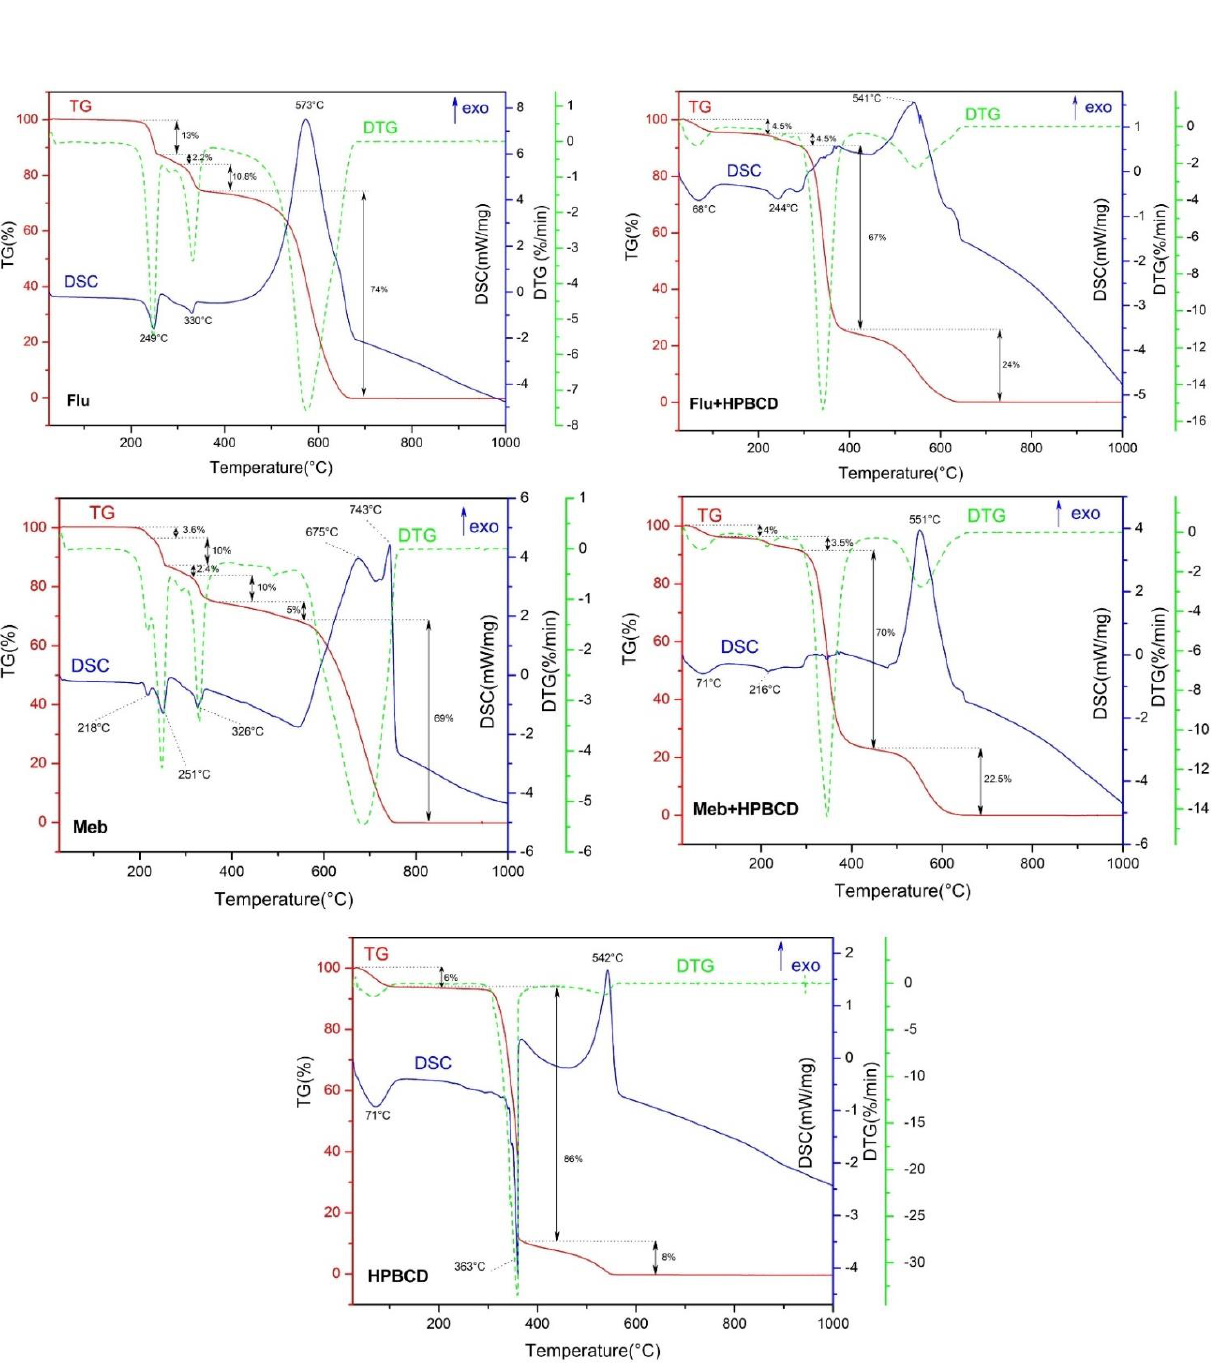
Figure 5. Thermal analysis for FLU, MEB, and their HPBCD physical